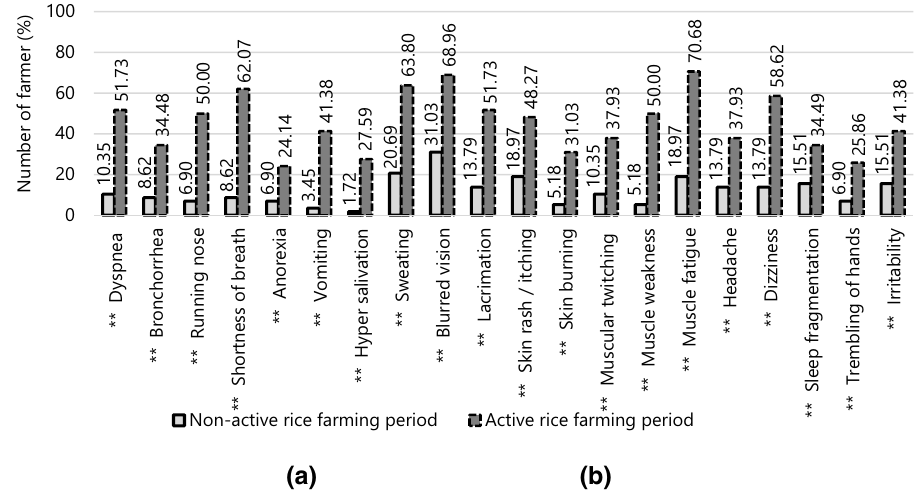
Figure 1. Comparison of health symptoms observed among the participants between the non-active rice farming period ( a ) and the active rice farming period ( b